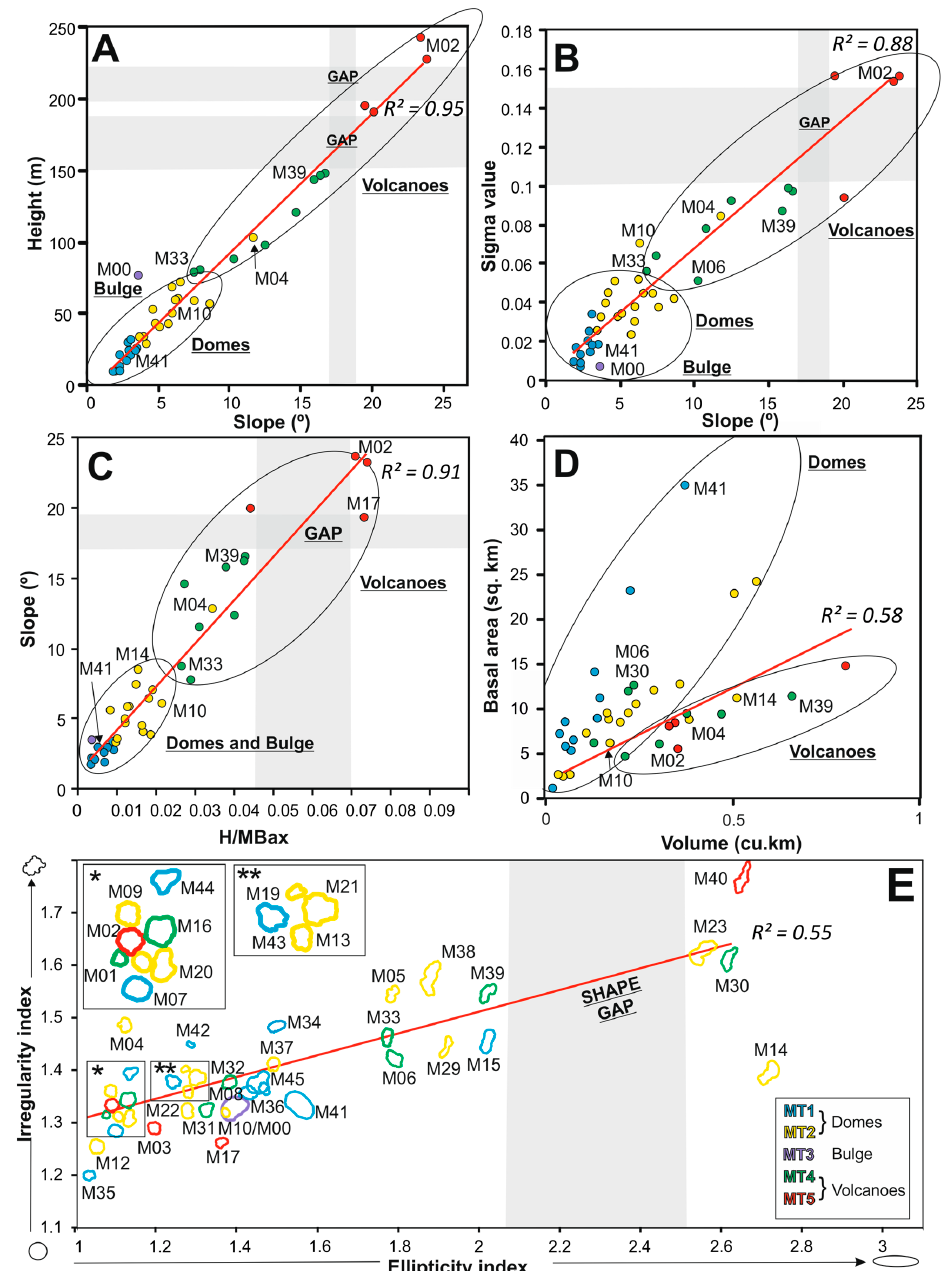
Figure 4. XY scatter plots of correlated variables for the forty mounds (n: 40). ( A , B ) Slope (X) vs. Height (Y) and Sigma Value, respectively; ( C ) Height/Basal length (X) vs. Slope (Y); ( D ) Volume (X) vs. Area (Y) where M00 is excluded being considered an outlier for Size Factor (F2); and ( E ) Ellipticity index (X) vs. Irregularity index (Y). The basal contour of each of the forty mounds is shown. All the mounds conserve their scale with the exception of M00. The red lines indicate the trend of each correlation and the R 2 coefficient is displayed next to them. The ellipses indicate the natural tendency of the edifices types to cluster, and gaps in the distribution are highlighted by shaded regions.